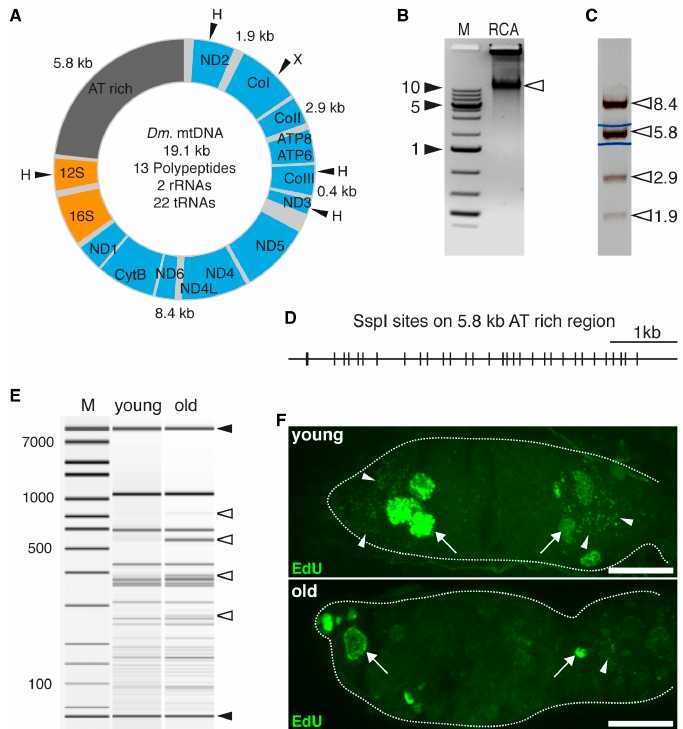
Figure 1. Mitochondrial DNA (mtDNA) rearrangements and impaired mtDNA replication in ovaries of aged flies. ( A ) Schematic drawing of Drosophila melanogaster (Dm.) mtDNA. Enzyme sites of HindIII (H) and XhoI (X) are indicated. Sizes of digested fragments are also labelled. ( B ) Representative gel image of rolling cycle amplification of mtDNA (arrowhead) and DNA marker (M, kb). ( C ) Pattern of rolling cycle amplification (RCA) amplified mtDNA digested by XhoI and HindIII. The 5.8 kb